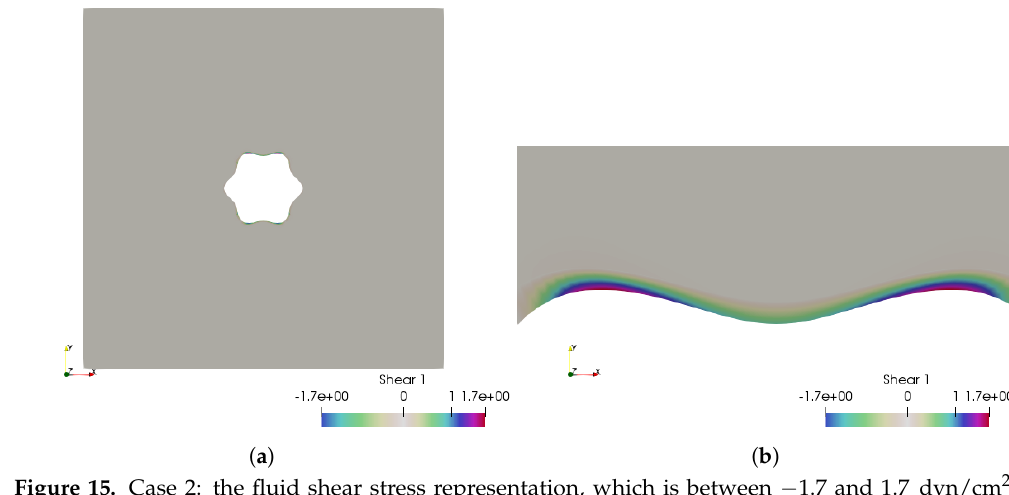
Figure 15. Case 2: the fluid shear stress representation, which is between − 1.7 and 1.7 dyn/cm 2 . ( a ) The fluid shear stress overview; ( b ) zoom over the higher shear stress